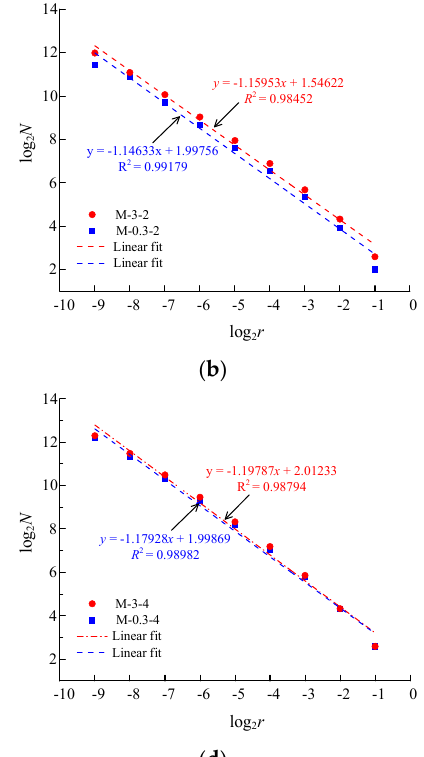
Figure 9. Grayscale images of the fracture surface of coal specimens and reverse binary images. ( a ) M-0.3-1; ( b ) M-0.3-2; ( c ) M-0.3-3; ( d ) M-0.3-4; ( e ) M-3-1; ( f ) M-3-2; ( g ) M-3-3; ( h ) M-3-4. Figure 10 shows the relationship between the log 2 N and log 2 r of coal specimens with different numbers of prefabricated cracks. The slope of the curve is the fractal dimension of the failure surface. As shown in Figure 10, the correlation coefficient of the fitted curve is greater than 0.98, indicating that coal specimens with different crack numbers have ob- vious fractal dimension characteristics[37–39].